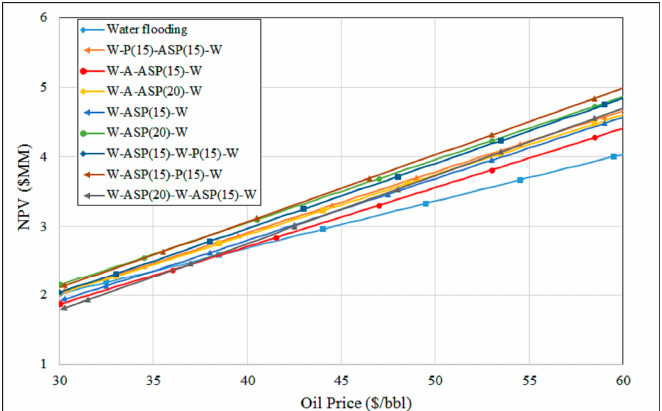
Figure 9. NPVs of different potential chemical flooding sequences and water flooding according to the change of the oil price from 30 to 60 $/bbl.